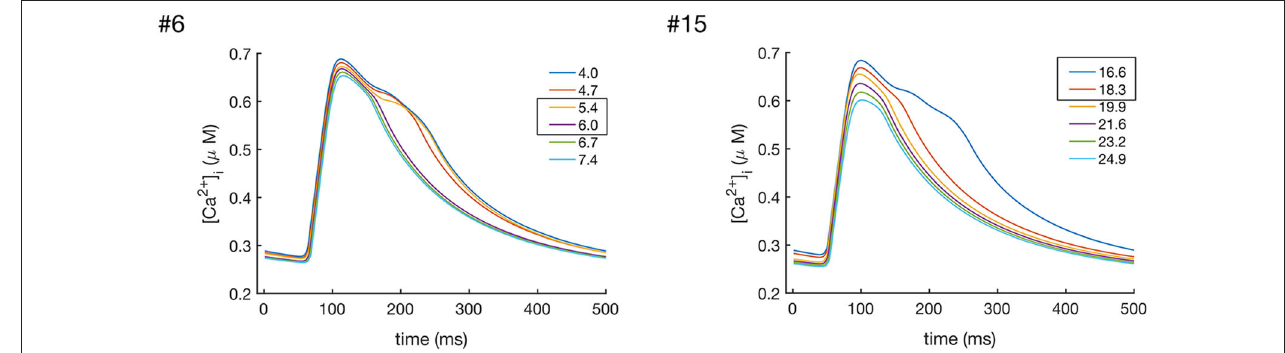
FIGURE 8 | Effects of increasing the values of I max NCX in models #6 and #15, which resulted in the enhanced Ca 2 + extrusion and a faster CaT c decay. In model #6 the transition between the biphasic and smooth CaT profile occurredat values of I max NCX between 5.4 and 6.0n S /pF, while in model #15 the transition occurred at values between 16.6 and 18.3n S /pF.